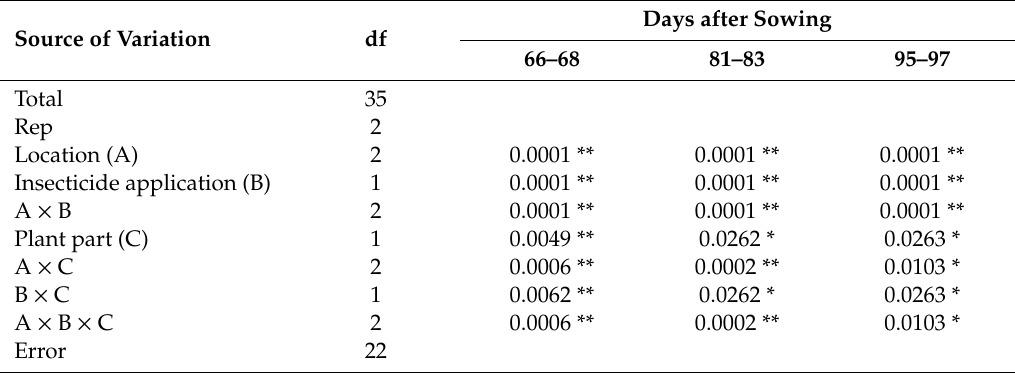
Table 9. Thiamethoxam (including chlothianidin) residues in di ff erent plant parts during the vegetation period in 2015.